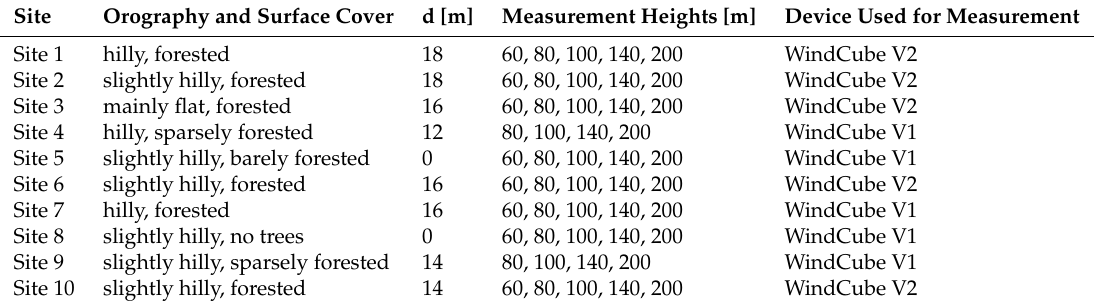
Table 1. Details of the measurement sites; d indicates the displacement height estimated as 2/3 of the height of trees near the measurement location (as often done in wind energy applications when performing vertical extrapolation [7,19,20]). The duration of each measurement is exactly one year. The measurements were carried out at different one-year periods between May 2014 and August 2018. At Sites 4 and 9, no measurement data were available at the 60 m